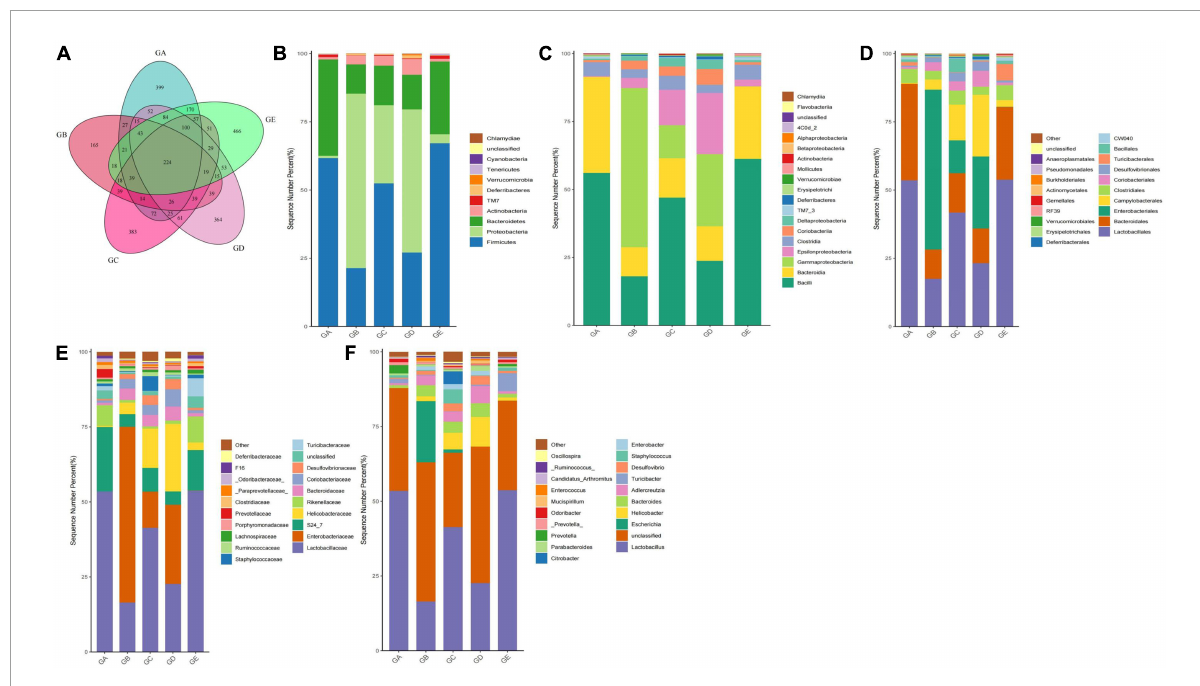
FIGURE5 BLBP partly restored the gut microbiota in mice induced by LPS in different taxa. (A) Venn diagram, (B) Phylum, (C) Class, (D) Order, (E) Family, (F) Genus.